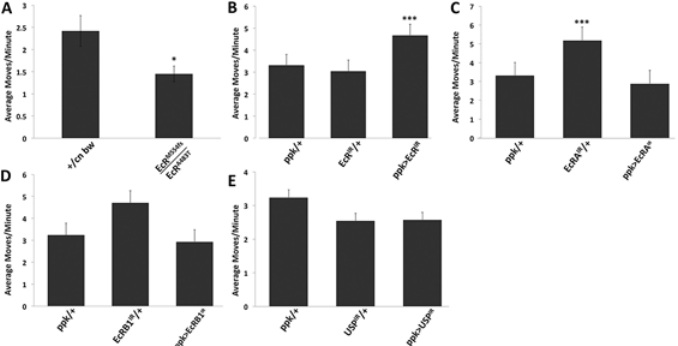
Fig 4. Analysis of ecdysone receptor mutant locomotion. Third instar larvae were assayed for spontaneous locomotor activity using the Drosophila activity monitor (DAM). Data were collected as moves per minute for each larva and averaged over a twenty-minute period. A Students t-test was used to determine statistical significance ( ** indicates p < 0.01, *** indicates p < 0.001), n = 32 per genotype. (A) Mutants bearing one null allele of EcR ( EcR M554fs ) and one temperature sensitive allele ( EcR A483T ) were significantly less motile (p < 0.011) than controls comprising the genetic backgrounds of each mutation (+ = Canton-S). (B) Locomotor activity was increased in larvae in which all EcR isoforms were suppressed specifically in nociceptor neurons. (C-E) The spontaneous locomotion of various other EcR and a USP RNAi driven by ppk- Gal4 were not significantly different from both controls.